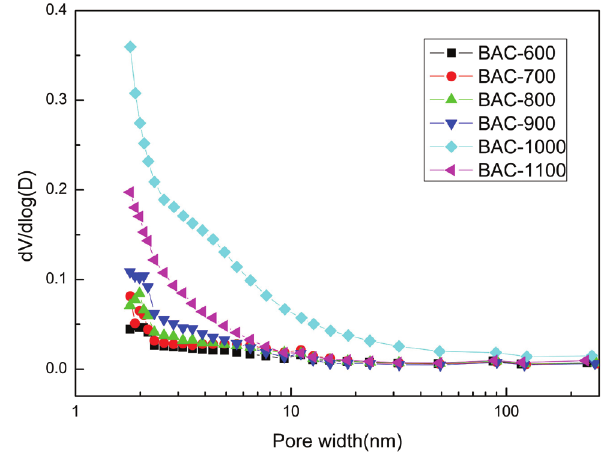
Figure 4: Pore size distribution of the